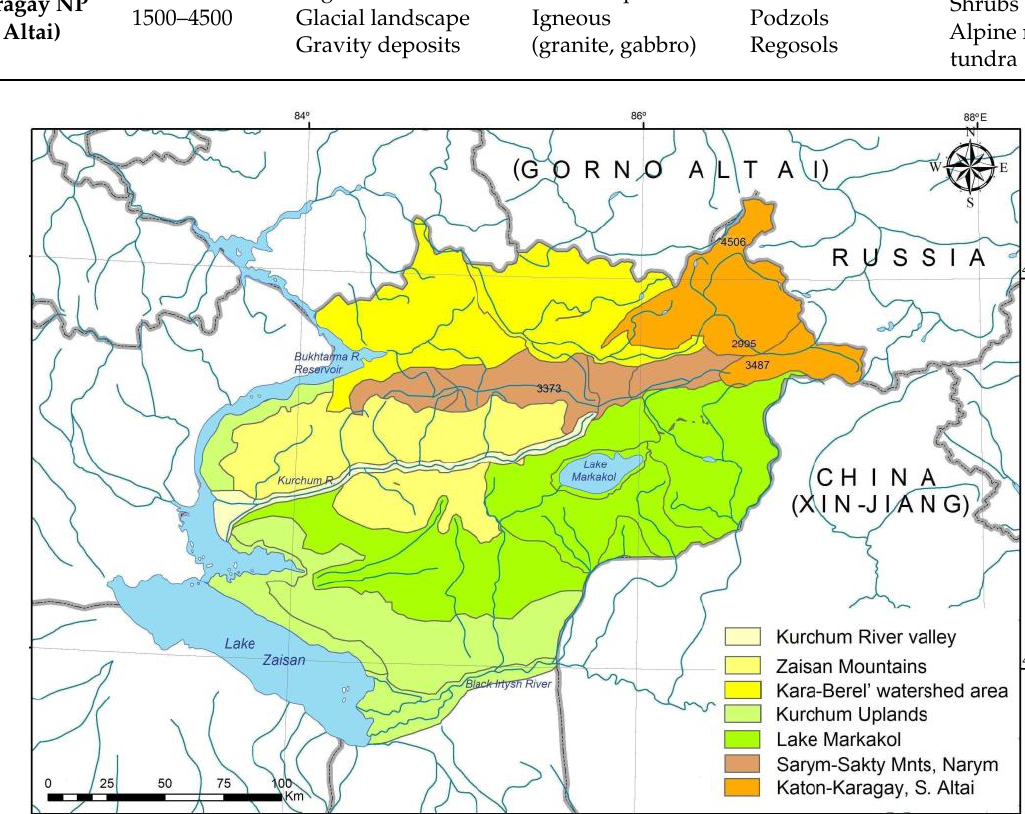
Figure 4. Spatial projection of the principal geographic recreation areas of the S. Altai territory.